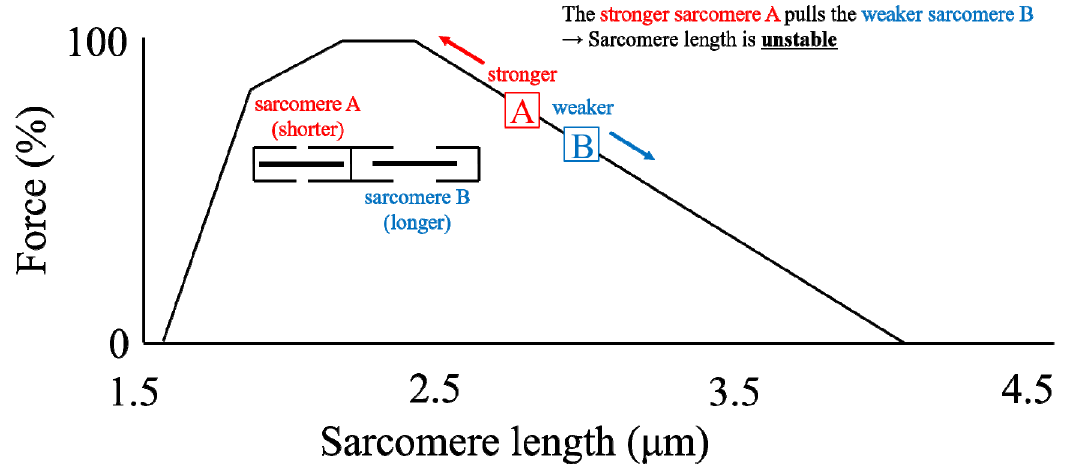
Figure 3. Schematic diagram of two non-uniform sarcomeres on the descending limb of the force-length relationship. Note that the shorter sarcomere A has a larger force-generating capacity than the longer sarcomere B. Thus, the shorter sarcomere A is thought to stretch the longer sarcomere B upon muscle contraction.